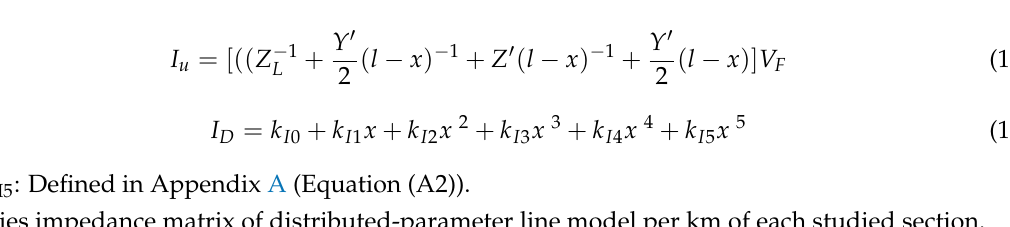
Figure 5. Updated voltage and current at fault location.